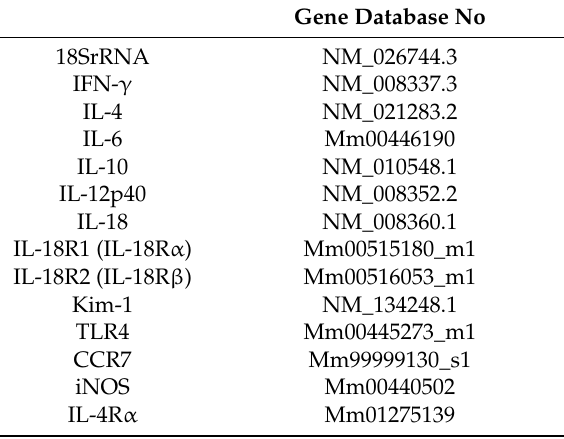
Table 5. Gene database number for analysis of mRNA